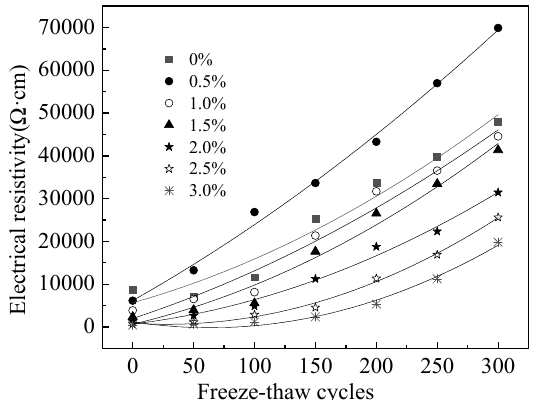
Figure 12. The electrical resistivity of MPC-RPC during NaCl F-T cycles. Table 6. The fitting results of the relationship between ρ and the N .